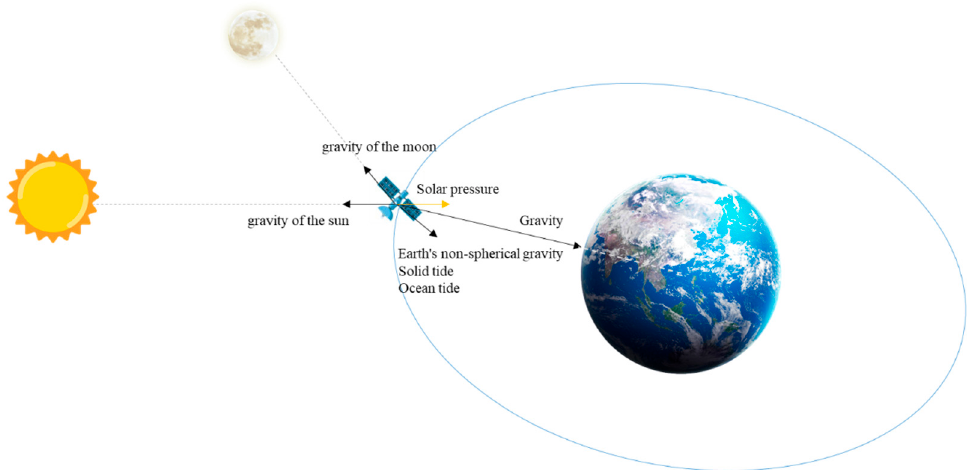
Figure 1. The orbital perturbation model of satellites under the factors of third-body gravity, non- uniform gravity, and light pressure.